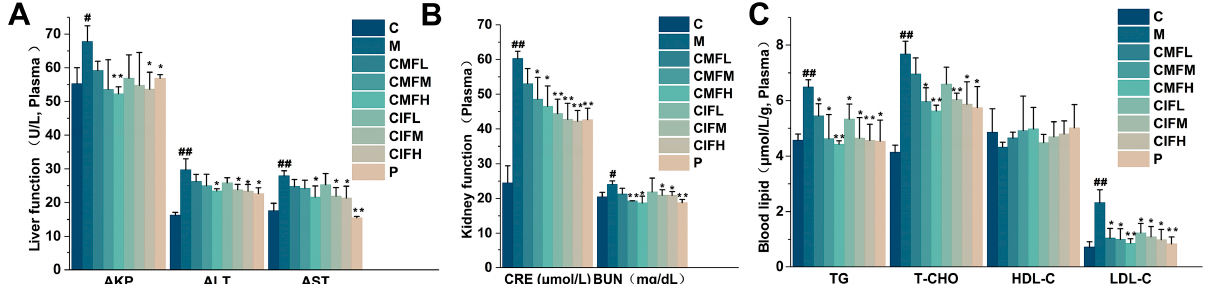
Figure 4. The power of CMF and CIF to resist functional damage. ( A – C )—Determined results of liver, kidney function indicators, and blood lipid indexes. Values shown are mean ± SD. # p < 0.05, ## p < 0.01 compared with C group; * p < 0.05, ** p < 0.01 compared with M group.